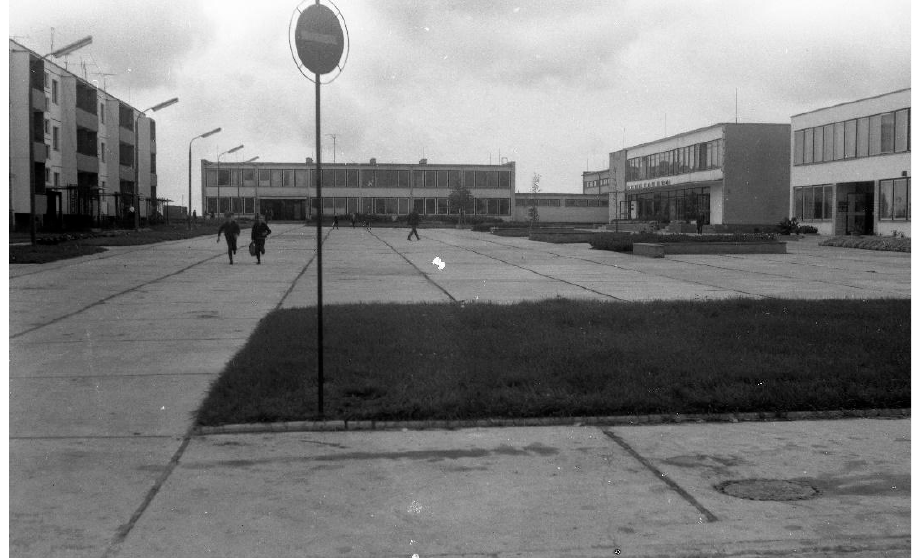
Figure 8. Community centre for Dainava settlement, 1970s. From the archive of the Institute of Architecture and Construction.